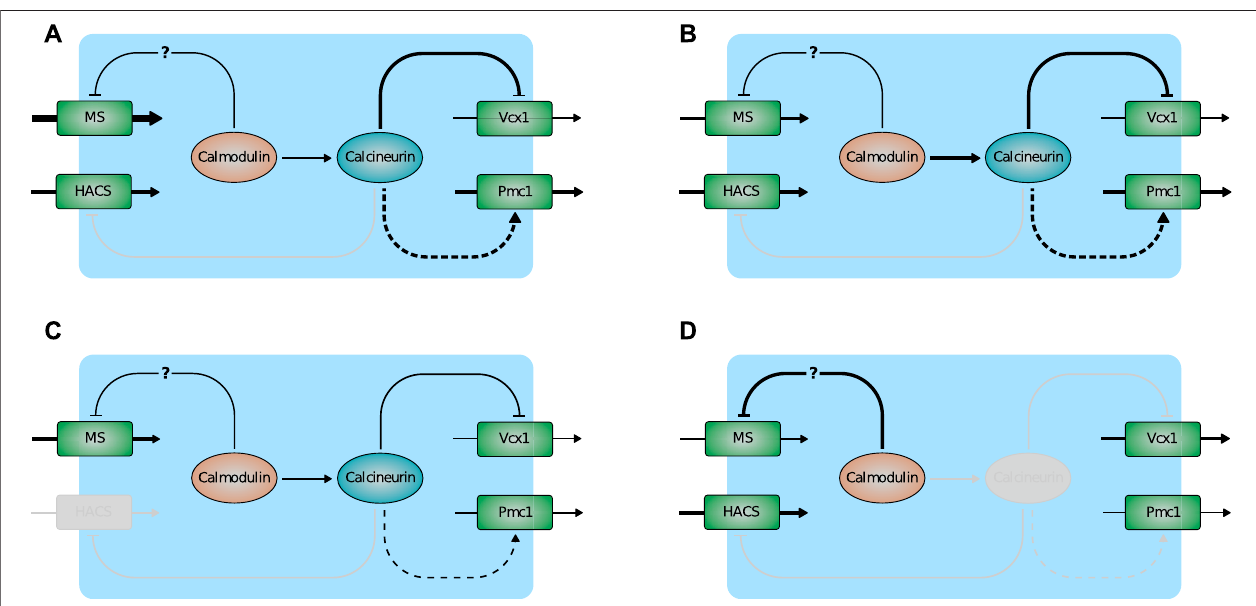
FIGURE 7 | Scheme depicting the main predictions of the model. (A) Wild-type. (B) fl c2 Δ . (C) cch1 Δ . (D) cnb1 Δ . Activation is indicated by arrows, inactivation by T-bar arrows. Plain anddashed lines indicate post-transcriptionaland transcriptionalregulations.Linethickness representsthestrenght of fl uxes/(in)activations. Inactive components of the pathway are